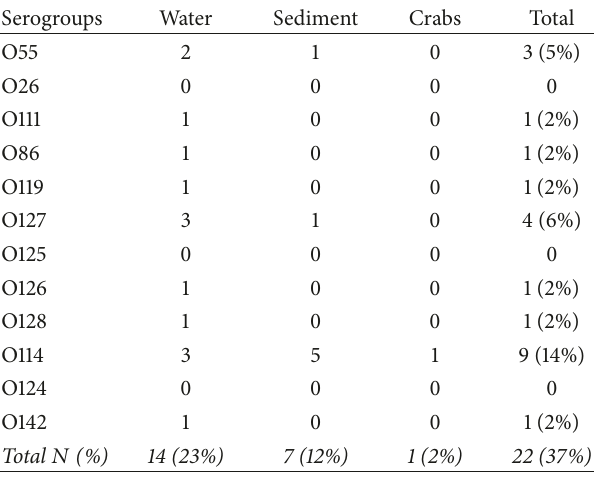
Table 5: Serogroups of potential pathogenic strains